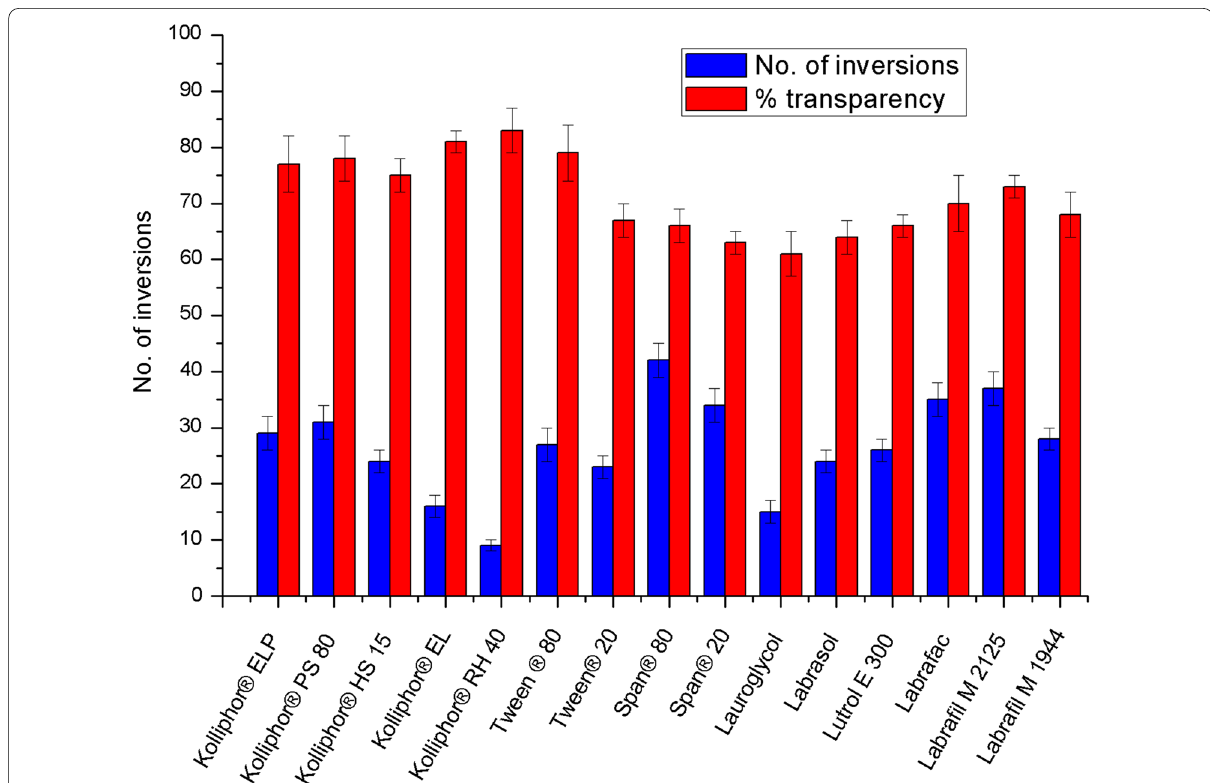
Fig. 3 Number of inversions and percent transmittance with different